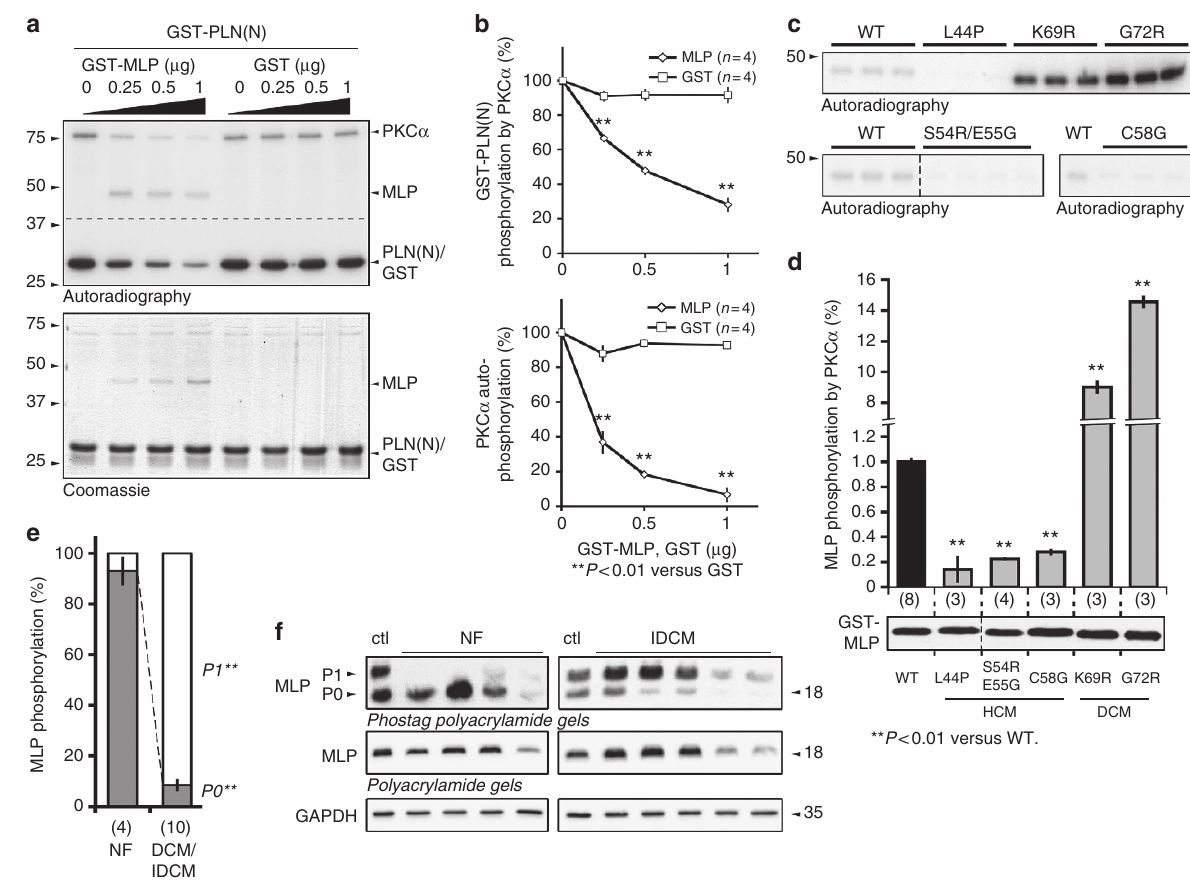
Figure 1 | MLP is a substrate and inhibitor of PKC a kinase activity in vitro . ( a ) In vitro kinase assay using PKC a and GST tagged phospholamban cytoplasmic N-terminus (GST-PLN(N)) as substrate with increasing GST-MLP or GST amounts. Shown are representative autoradiography images for phosphorylated proteins (upper panel) or Coomassie staining for total proteins (lower panel). Dashed line indicates that proteins were run on the same gel, but imaged using different exposure times. ( b ) Quantification of GST-PLN(N) phosphorylation or PKC a auto-phosphorylation with increasing GST-MLP or GSTconcentrations. Mean values with s.e., sample size ( n ) and P values are shown. ( c ) In vitro kinase assay using PKC a and GST tagged WTand mutant MLP as substrate. Representative autoradiography images for either Leu44Pro (L44P), Lys69Arg (K69R), Gly72Arg (G72R) mutant MLP (top panel), or Ser54Arg/Glu55Gly (S54R/E55G) or Cys58Gly (C58G; bottom panel) mutant MLP (bottom panel) in comparison with WT MLP are shown. Dashed line indicates proteins were run on the same gel, but non-consecutive. ( d ) Quantification of MLP phosphorylation by PKC a . Phosphorylation efficiency of WT MLP was arbitrarily set to 1. Mutants identified in human HCM patients show lower MLP phosphorylation, while MLP mutants associated with DCM display increased phosphorylation values. A representative Coomassie stained gel showing total GST-tagged MLP used for in vitro kinase assays is depicted (bottom panel; dashed line indicates that proteins were run on the same gel, but non consecutive.). Shown are mean values and s.e., as well as P values and sample sizes ( n , in brackets below bar graphs). ( e , f ) Analysis of MLP phosphorylation in IDCM. ( e ) Quantification of MLP phosphorylation indicates significantly elevated phosphorylation levels in IDCM patients, compared to NF controls. Shown are mean values and s.e., as well as sample size ( n , in brackets below bar graphs), and P values. ( f ) MLP phosphorylation levels for quantification in ( e ) were determined by Phostag analysis. SDS samples of protein extracts of NF and IDCM patient heart samples were run on conventional SDS PAGE (middle) and on 12% polyacrylamide gels with 50 m M Phostag reagent (top) and immunoblotted for MLP. A human control sample with uncharacterized disease status (ctl) showing non-phosphorylated (P0) and phosphorylated (P1) MLP was used to indicate Phostag gel migration pattern. Phosphorylated proteins (P1) migrate slower due to their interaction with the Phostag reagent compared to unphosphorylated protein (P0). GAPDH (bottom) was used to show equal